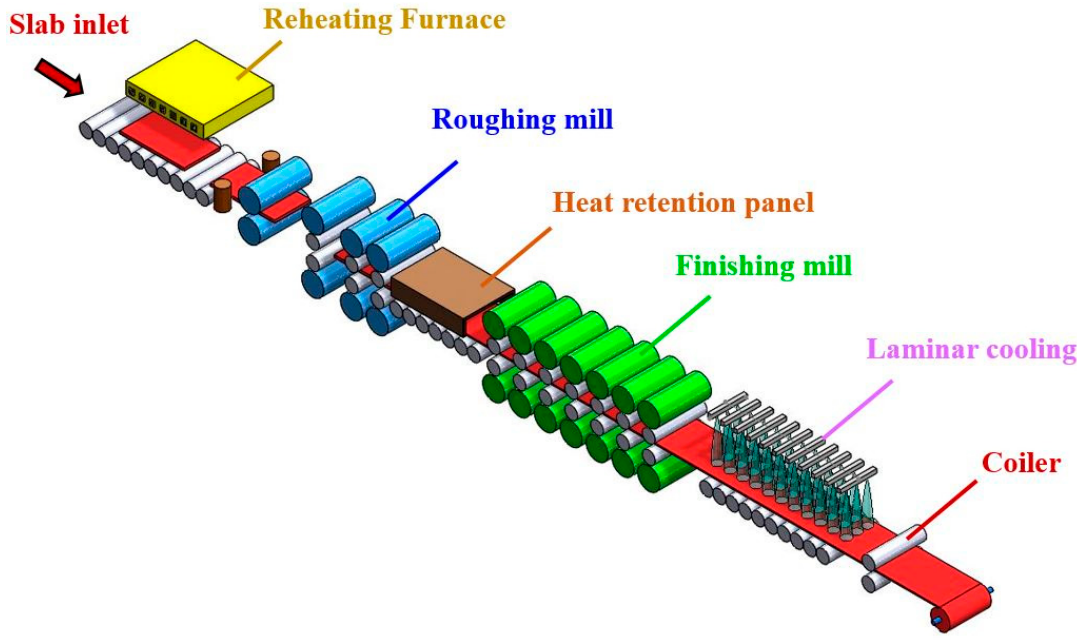
Figure 1. Hot strip rolling process configuration. 114